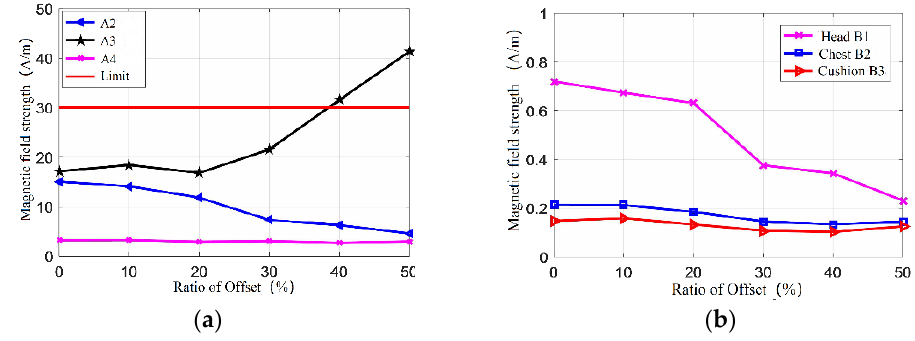
Figure 16. Magnetic field strength: ( a ) test points of A2, A3, A4; ( b ) test points of B1, B2, B3.